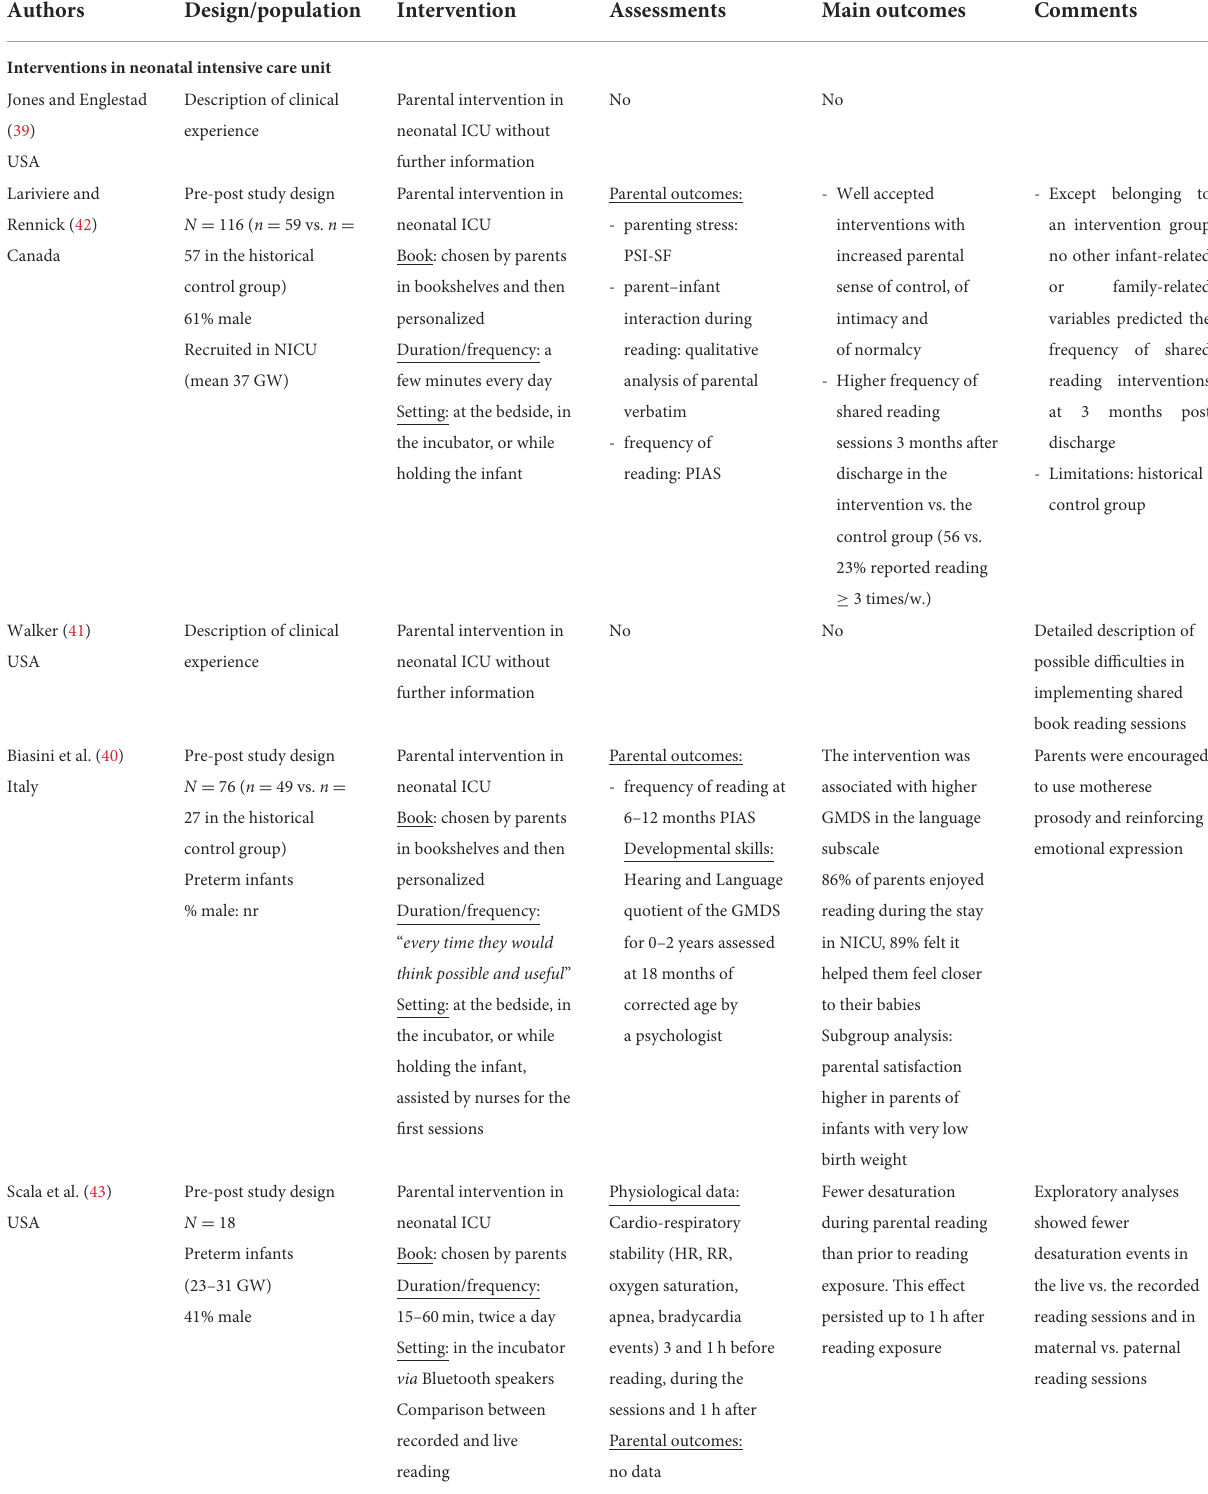
TABLE 1 Studies describing shared reading interventions in premature